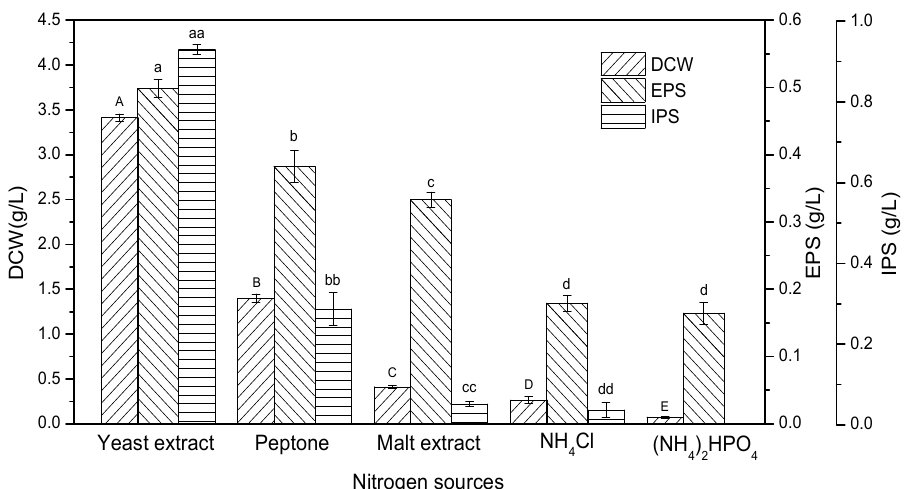
Figure 3. Effect of different nitrogen sources on mycelial growth (DCW: dry cell weight) and polysaccharides (EPS: exopolysaccharide; IPS: intracellular polysaccharide) production. The letters above bars are the same indication as shown in Figure 1.